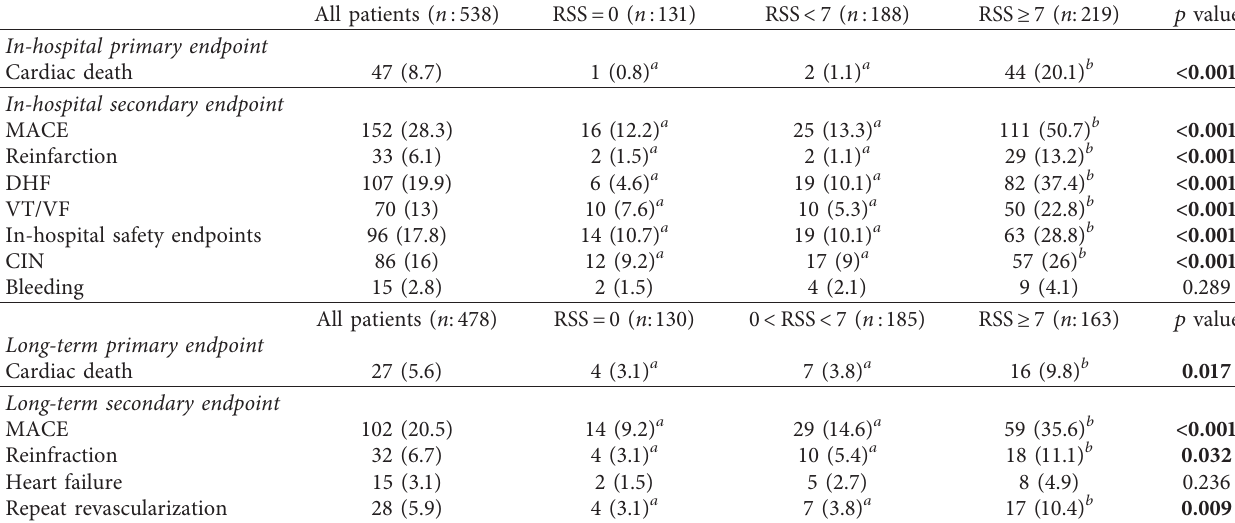
Table 4: In-hospital and long-term adverse events according to RSS. All patients ( n :538)